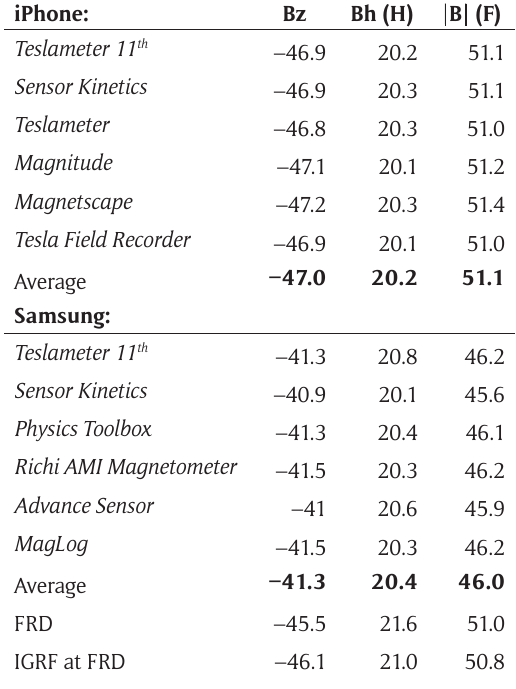
Table 8: Comparison of Platforms and Apps with the FRD Absolute